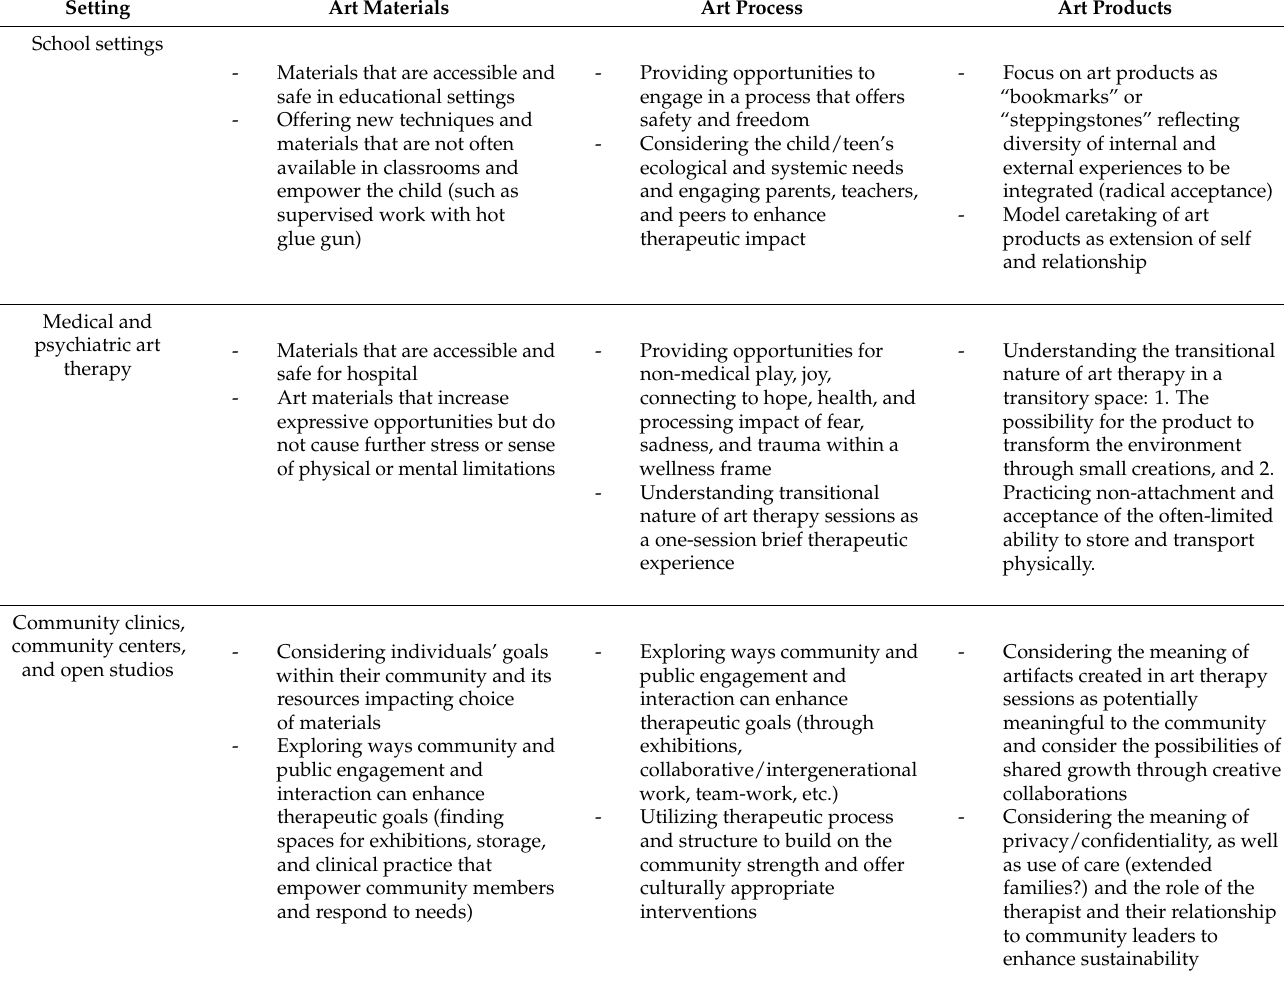
Table 1. Working with Children in Context: Summarizing art therapy research findings and theoretical models into applicable clinical